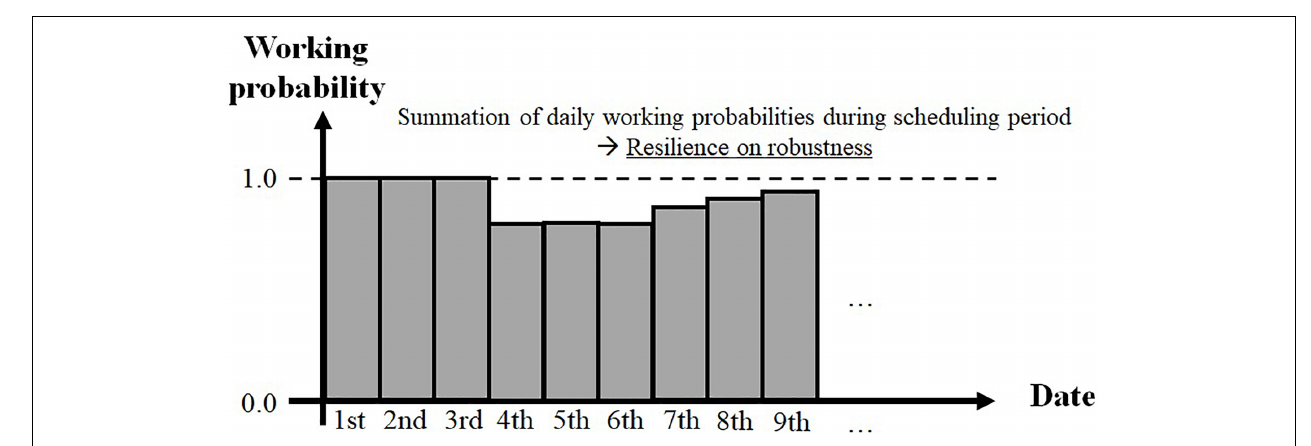
FIGURE 7 | Index of